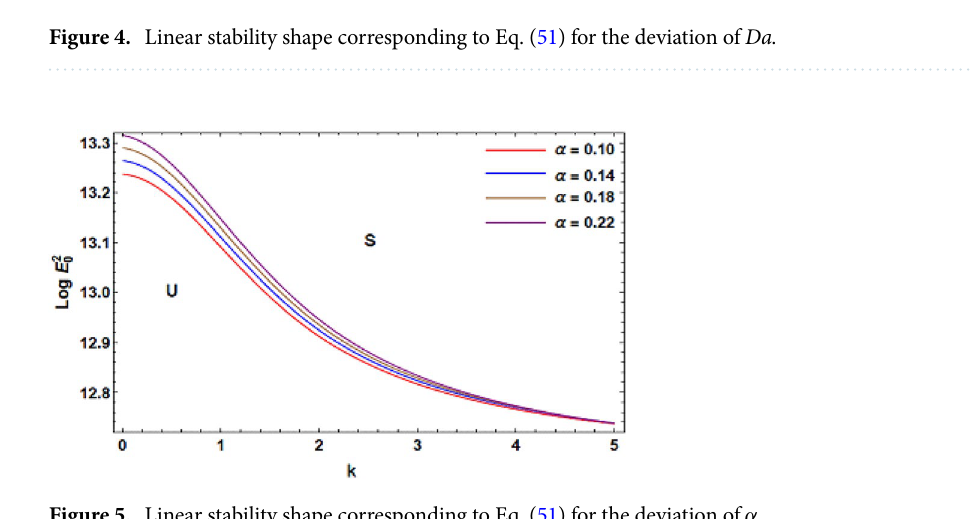
Figure 5. Linear stability shape corresponding to Eq. (51) for the deviation of α